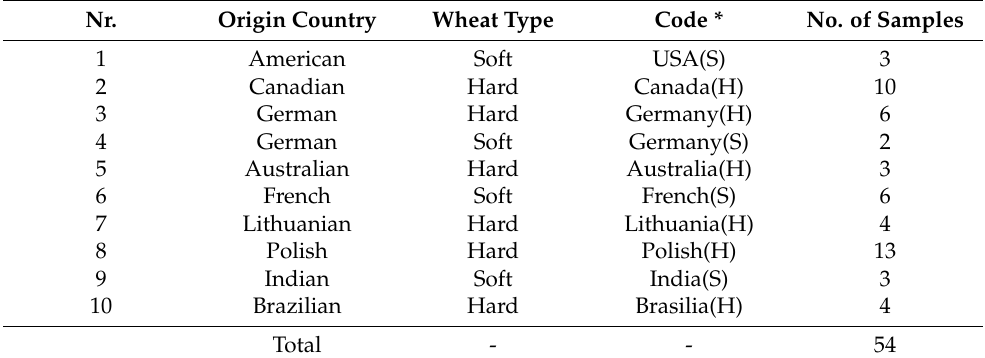
Table 4. Random representative sample origin, wheat type, code, and number of collected samples. Nr. Origin Country Wheat